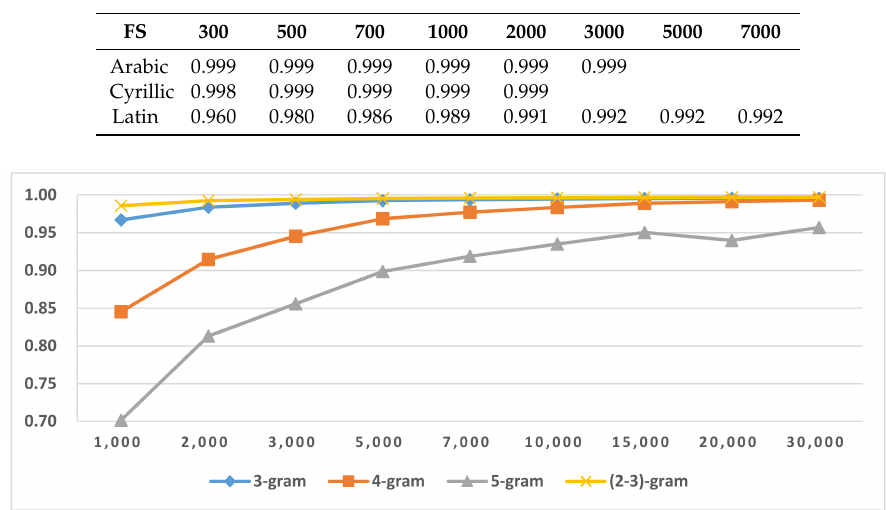
Table 18. LGI in different script languages when using DFS and two-gram.